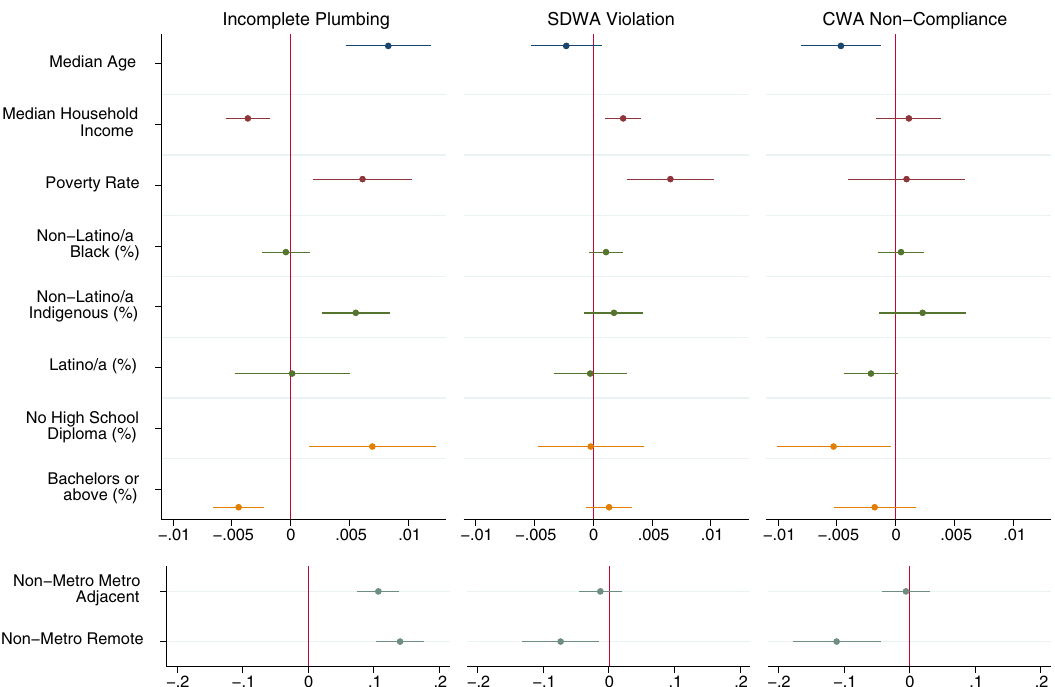
Fig. 4 Coef fi cient plot of descriptive regression model results. Different colors for plotted coef fi cients represent separate blocks of variables. Models are linear probability models with state fi xed effects and cluster-robust standard errors at the state level. All tests two-tailed. Dots indicate point estimates and lines represent 95% con fi dence intervals. Models predicted elevated levels of each dimension of water hardship. For incomplete plumbing this is indicated by >1% of households in a county having incomplete plumbing ( N = 3219). For Safe Drinking Water Act (SDWA) Serious Violation this is indicated by >1% of active community water systems being considered Serious Violators ( N = 3143). For Clean Water Act (CWA) Signi fi cant Non-Compliance this is indicated by >1% of Clean Water Act permittees being considered in Signi fi cant Non-Compliance ( N = 3207). Full model results, con fi dence intervals, and exact p -values available in